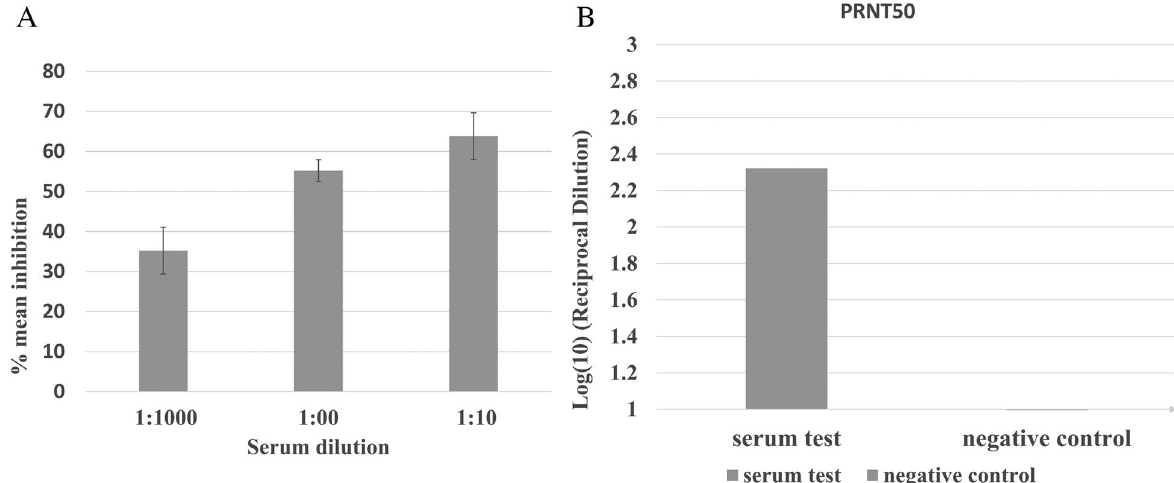
Fig. 3 PRNT assay of the polyclonal antibodies produced by AcRBD-sfGFP-V immunization in BALB/C mice. A The bar chart shows the percent viral inhibition after 10-fold serial dilution. B A nonlinear relation is blotted and giving the equation y substituted with 50 representing the neutralization titer (PRNT 50 ) of SARS CoV-2 in Vero cells with PRNT 50 > 100 shown in the bar chart with respect to the negative control (no